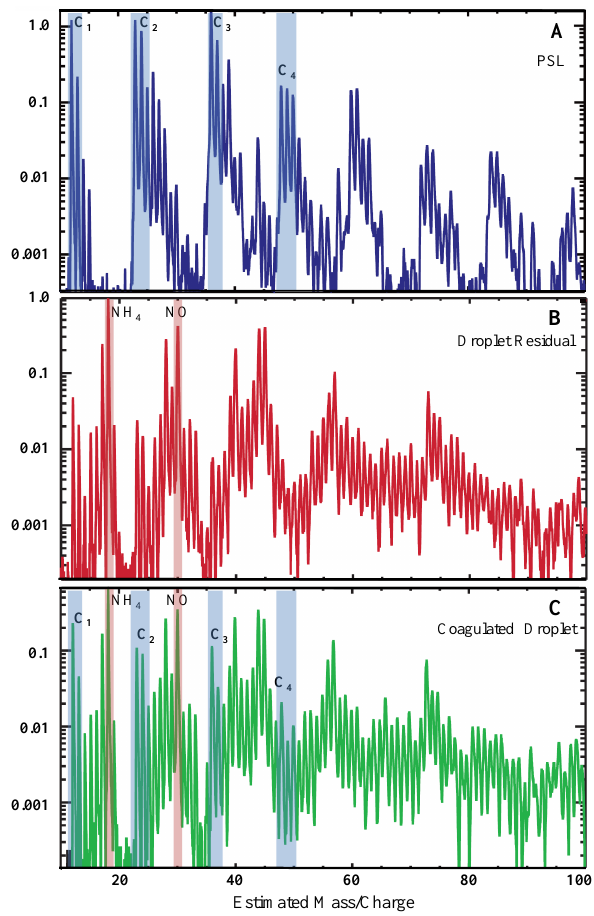
Figure 3. Mass spectra of a PSL particle (a) , an evaporated droplet composed of dilute AS, termed a droplet residual (b) , and a coagu- lated and evaporated droplet that contained both a PSL particle and residual AS (c)